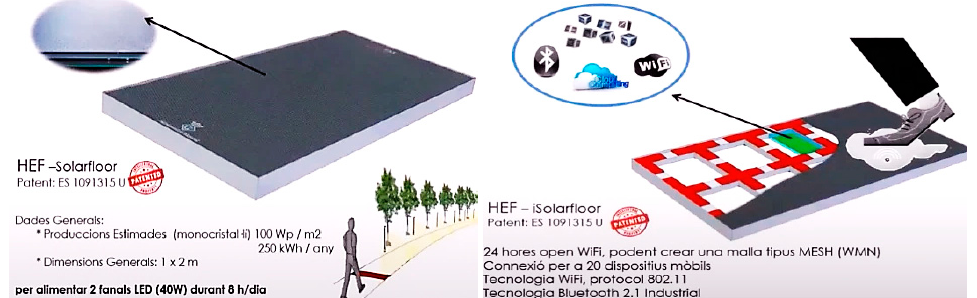
Figure 34. HEFs based on photovoltaic panels and EnergyFloors electromechanical technology [79].